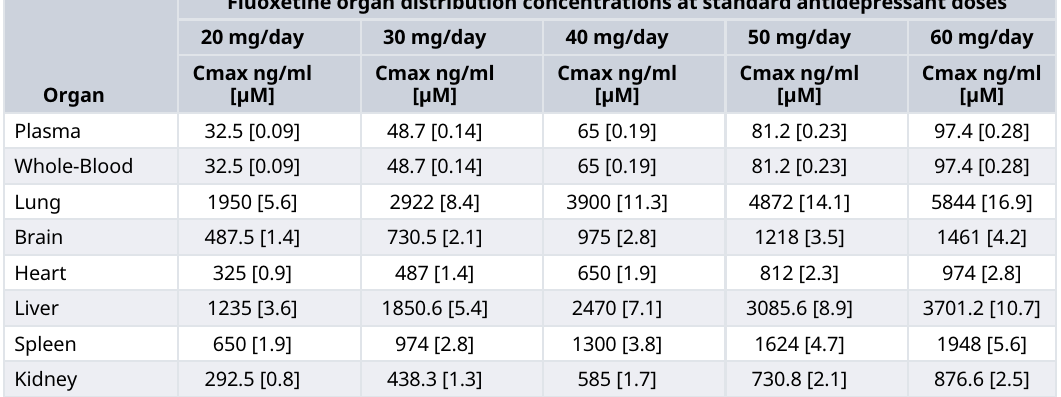
Table 1. Fluoxetine pharmacokinetics showing median organ concentrations (ng/mL and μ M) aiming to achievethetarget SARS-CoV-2EC50(283.6 ng/ml [0.82 μ M])and EC90(1390.1 ng/ml[4.02 μ M])during byday-10 of treatment in humans.